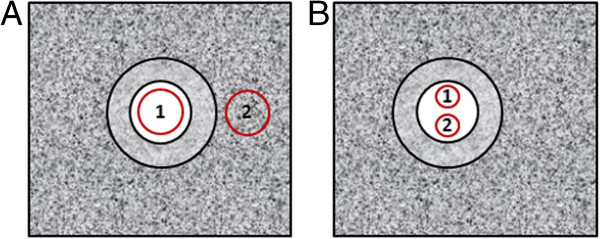
Off-line measurements. A) Illustration of the contrast to tissue ratio (CTR) measurements in the short axis view of the flow phantom. Two identical regions of interest (ROIs) were placed at the same depth in the short axis view; ROIVessel (1) and ROITissue (2), B) Illustration of the acoustic shadowing measurements with two identical ROIs placed underneath each other in the phantom vessel lumen; ROIupper(1) and ROIlower (2).